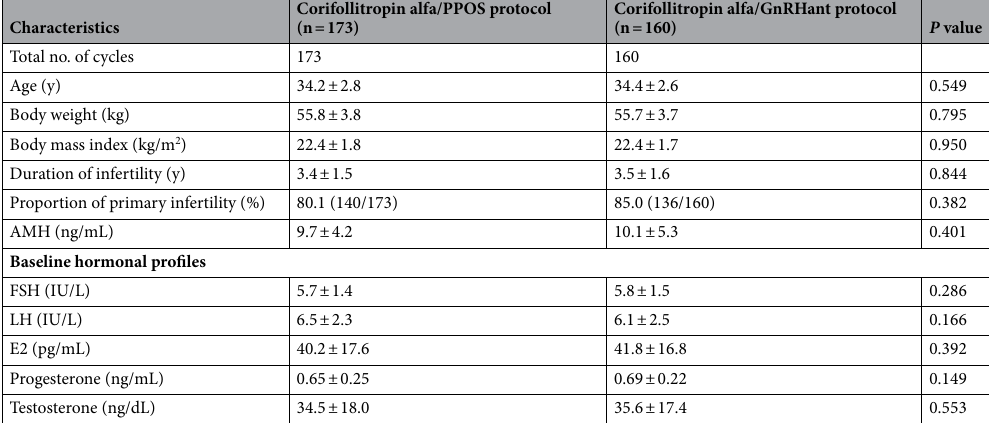
Table 1. Patient demographics and baseline characteristics. Values are expressed as number, mean ± standard deviation or percentage. PPOS progestin primed ovarian stimulation, GnRHant GnRH antagonist, AMH anti- Mullerian hormone, FSH follicle-stimulating hormone, LH luteinizing hormone, E2 Estradiol.